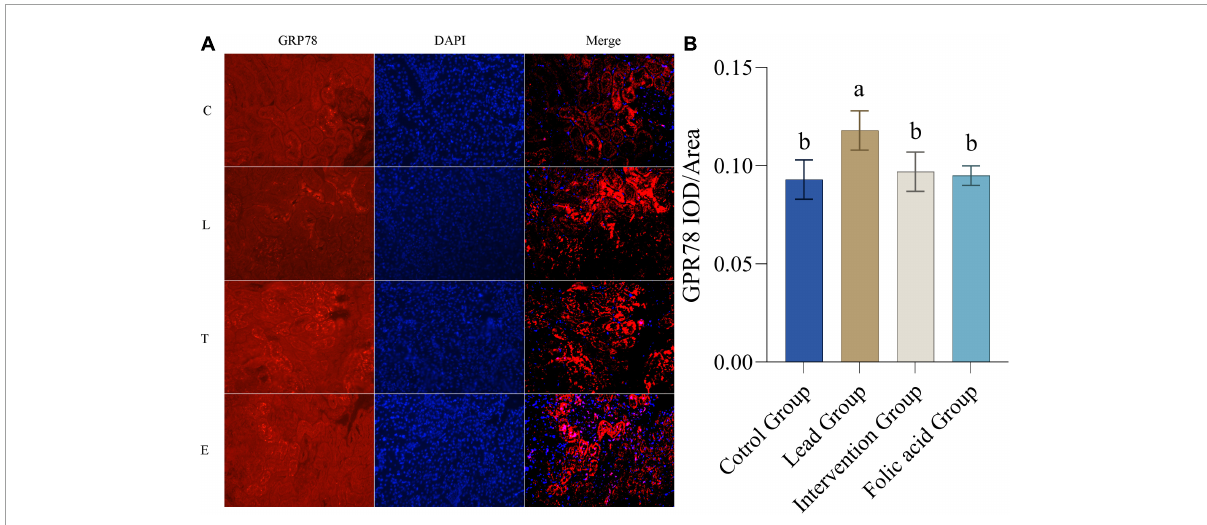
FIGURE6 Effect of folic acid on the expression of glucose-regulated protein 78 (GRP78) protein in the kidney of lead exposed rats. (A) Immunofluorescence results of GRP78 protein expression (200 × ). (B) The expression level of GRP78 protein is represented by the average integrated optical density value ( n = 6). C: control group; L: lead-exposed group; T: intervention group; E: folic acid group. Data were presented as mean ± SD. Different superscript letters indicate differences ( P <